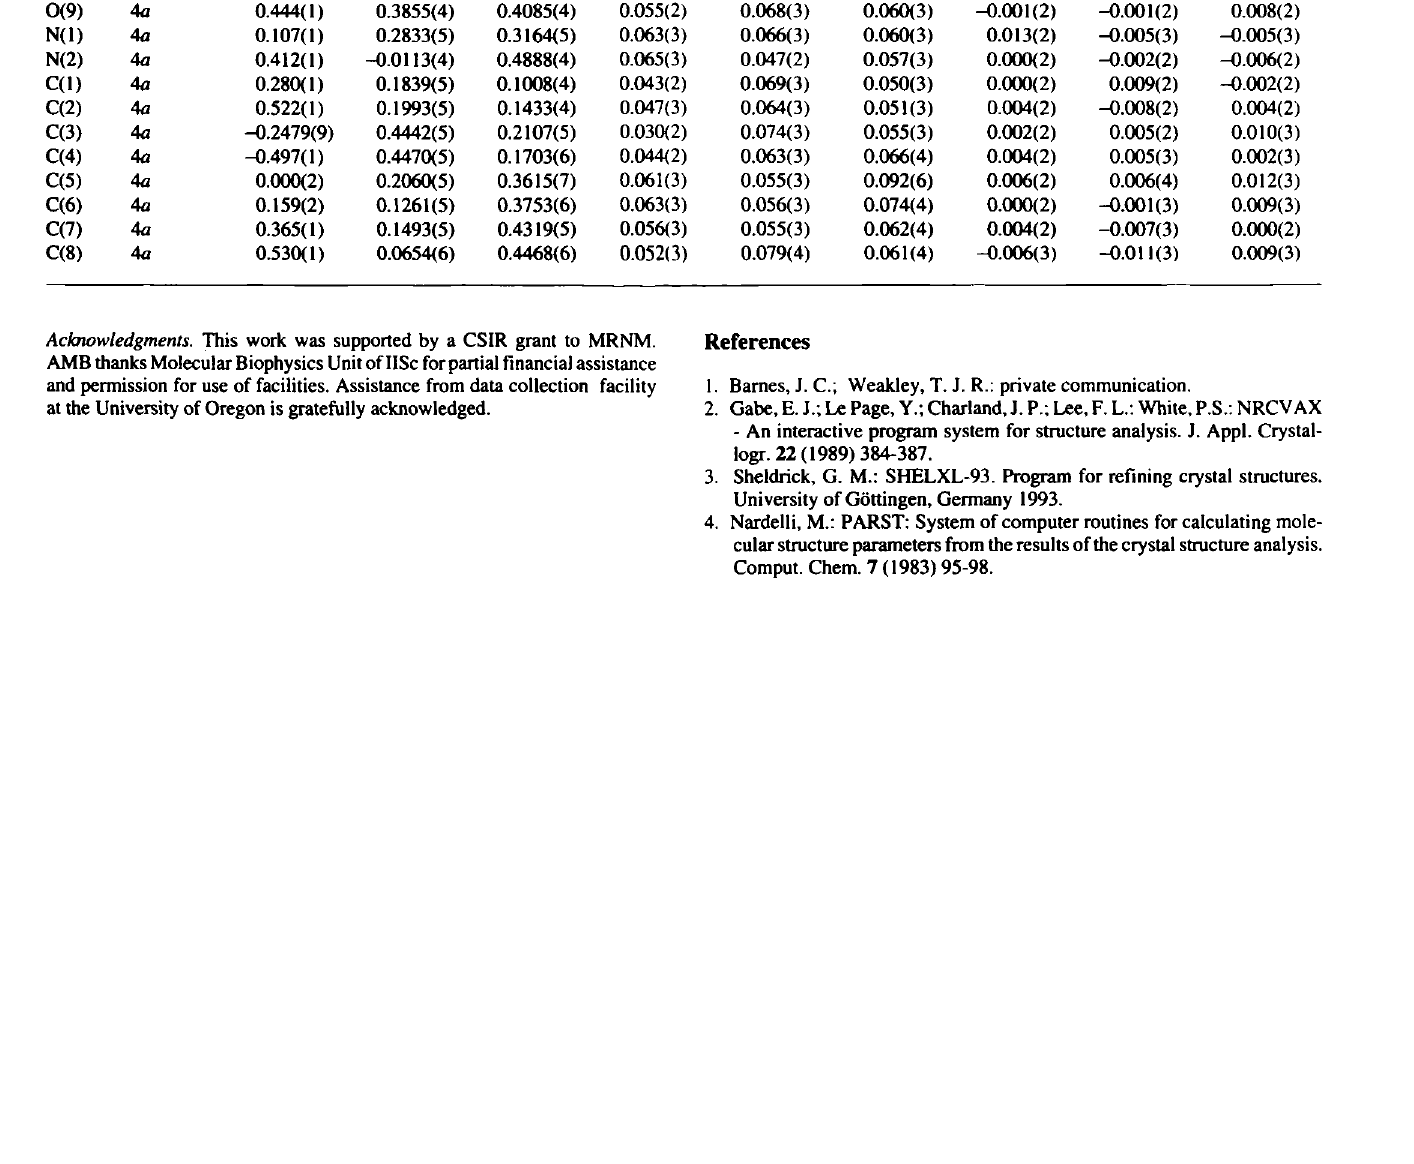
Table 3. Final atomic coordinates and displacement parameters (in